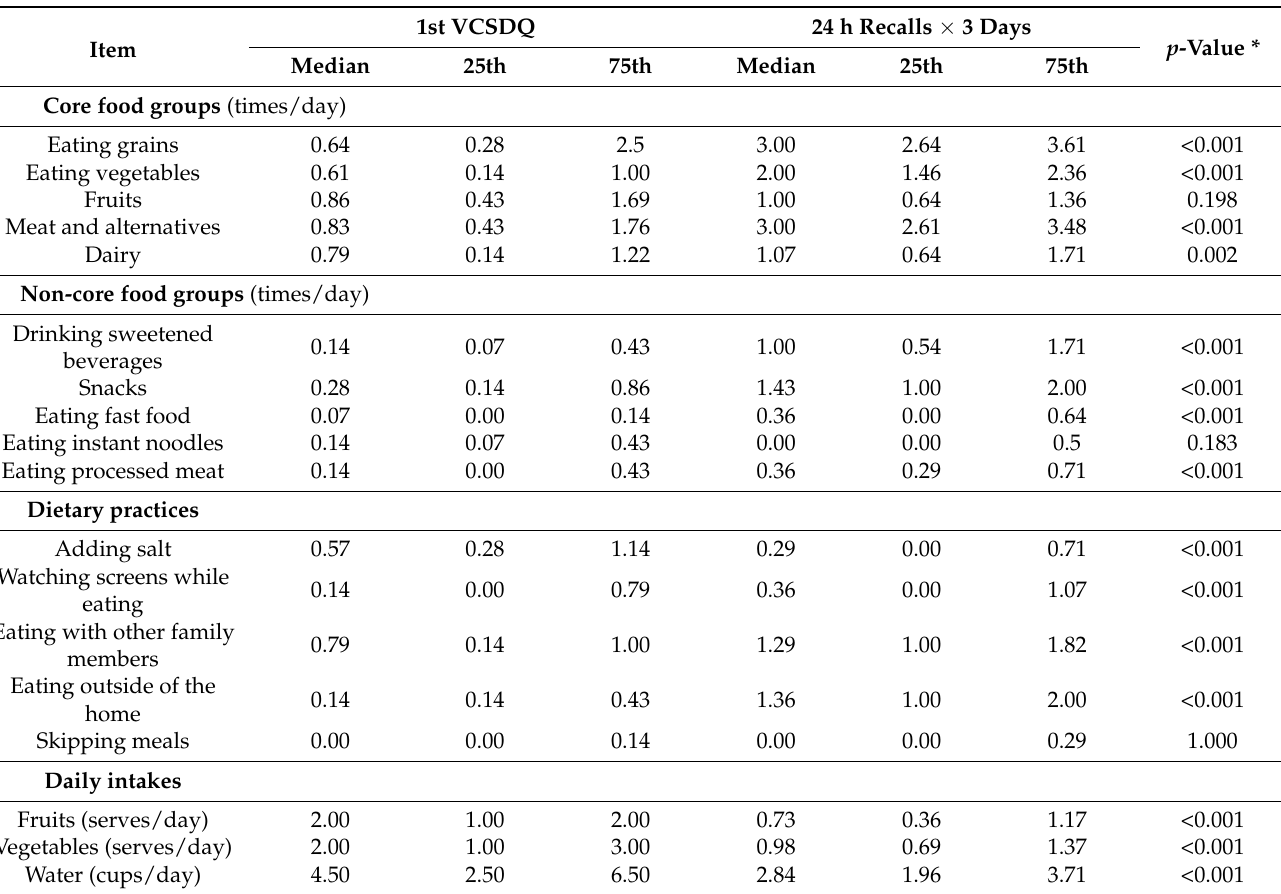
Table 3. Median frequency intake and frequency of dietary practices per day from the 1st VCSDQ and 24 h recalls ( n =